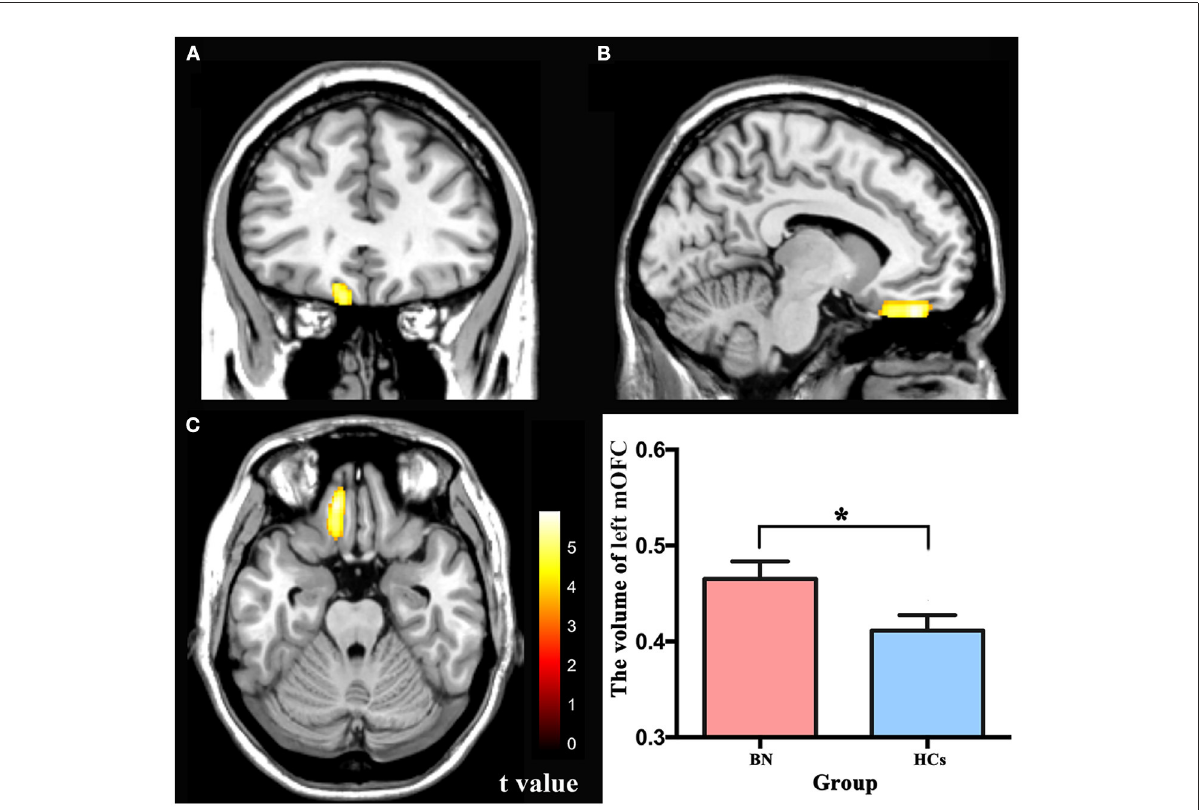
FIGURE1 (A–C) The yellow region indicates larger GMV of the left mOFC in the bulimia nervosa patients than in the healthy controls (voxel-level p < 0.001 uncorrected and cluster-level p < 0.05 FWE-corrected). GMV, gray matter volume; mOFC, medial orbitofrontal cortex; FWE, family